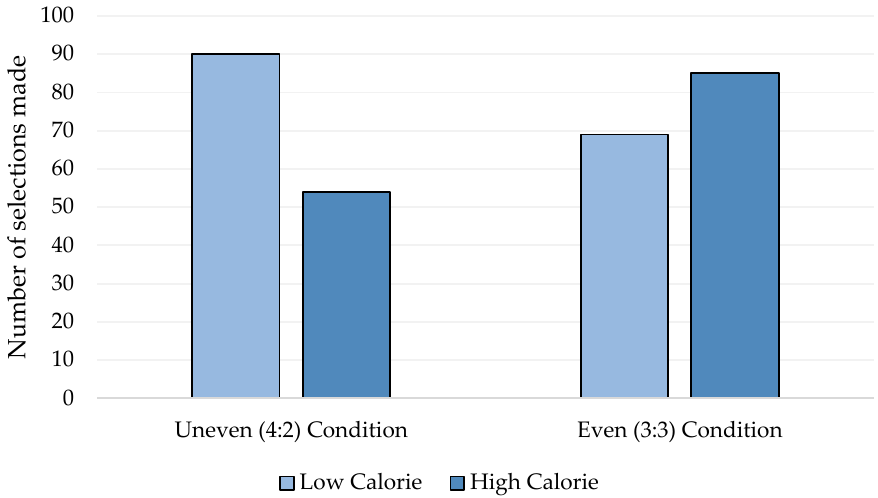
Figure 1. The frequency of low calorie ( ≤ 101 kcal) and high calorie (>201 kcal) selections made across the even (3:3 availability) and uneven (4:2 availability) conditions.